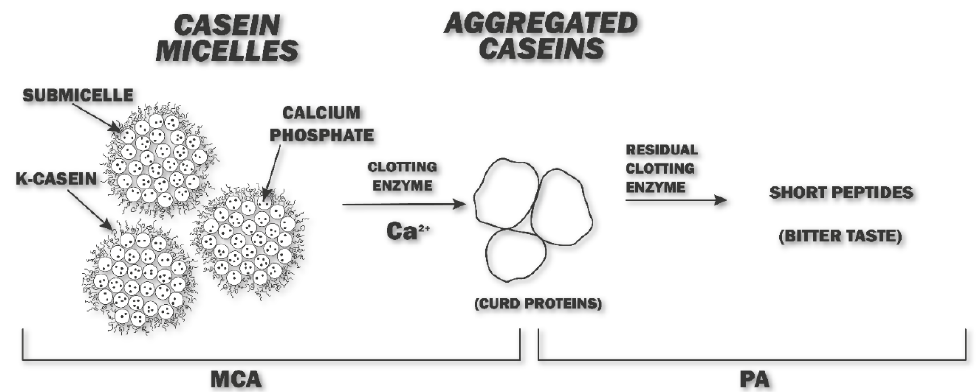
Figure 1. Degradation of caseins by clotting enzyme and development of bitter peptides. MCA = Milk-clotting activity, PA = Proteolytic activity.